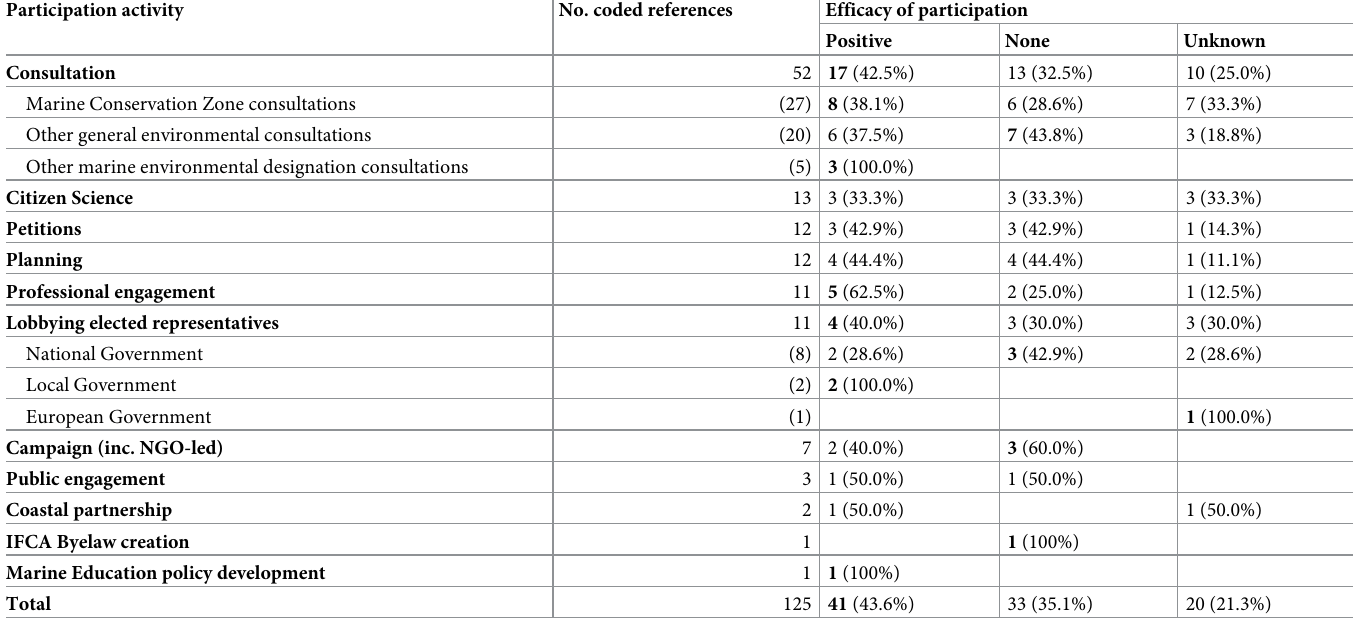
Table 7. Participation in marine decision-making. Summary of types of participation in marine decision-making from a group of active marine citizens. N = 78. Some respondents detailed more than one activity. Respondent perception of efficacy of the participation is provided for each activity type, where that information was provided, together with a percentage proportion of those data. For ease, bolded figures indicate the majority outcome for each activity type.